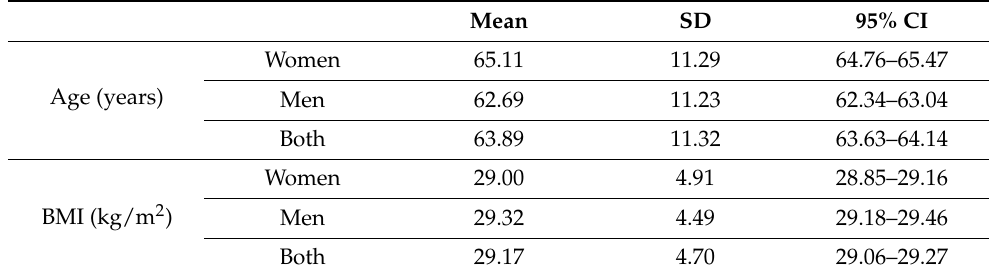
Figure 3. Age groups according to sex.